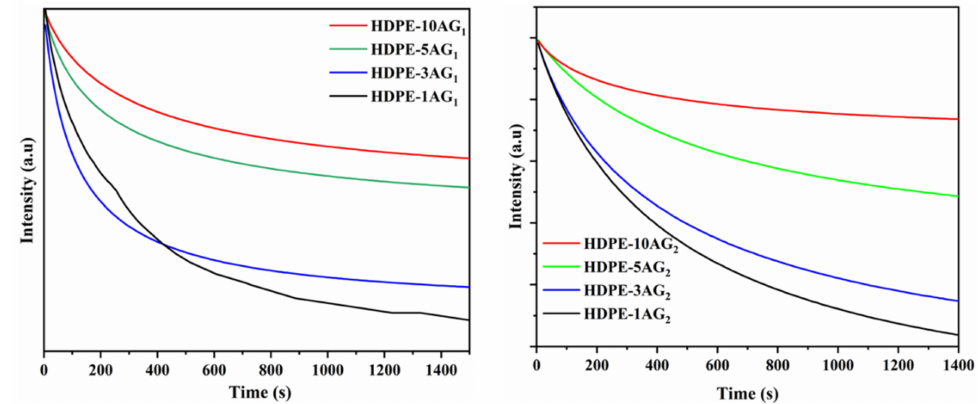
Figure 8. Phosphorescence intensity vs. time in HDPE/AG 1 and HDPE/AG 2 composites.